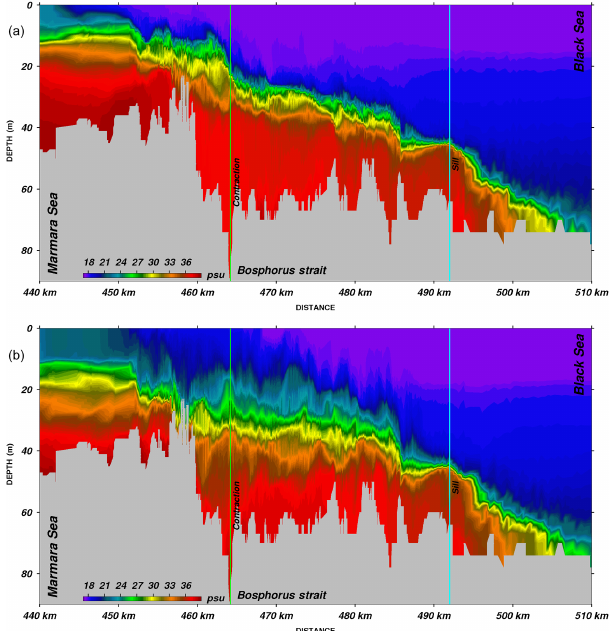
Figure 13. Same as Fig. 12 but for the Dardanelles strait and its Sea of Marmara